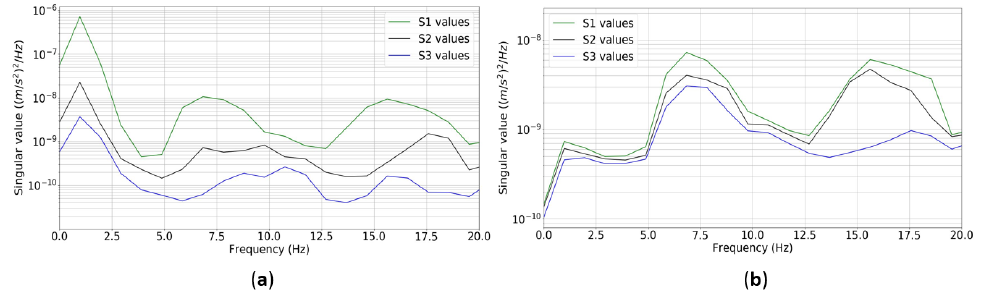
Figure 27. Vertical dynamic response of the 3-DOF structure in the frequency domain: ( a ) SVD spectrum of the reference SHM system. ( b ) SVD spectrum of the low-cost SHM system.